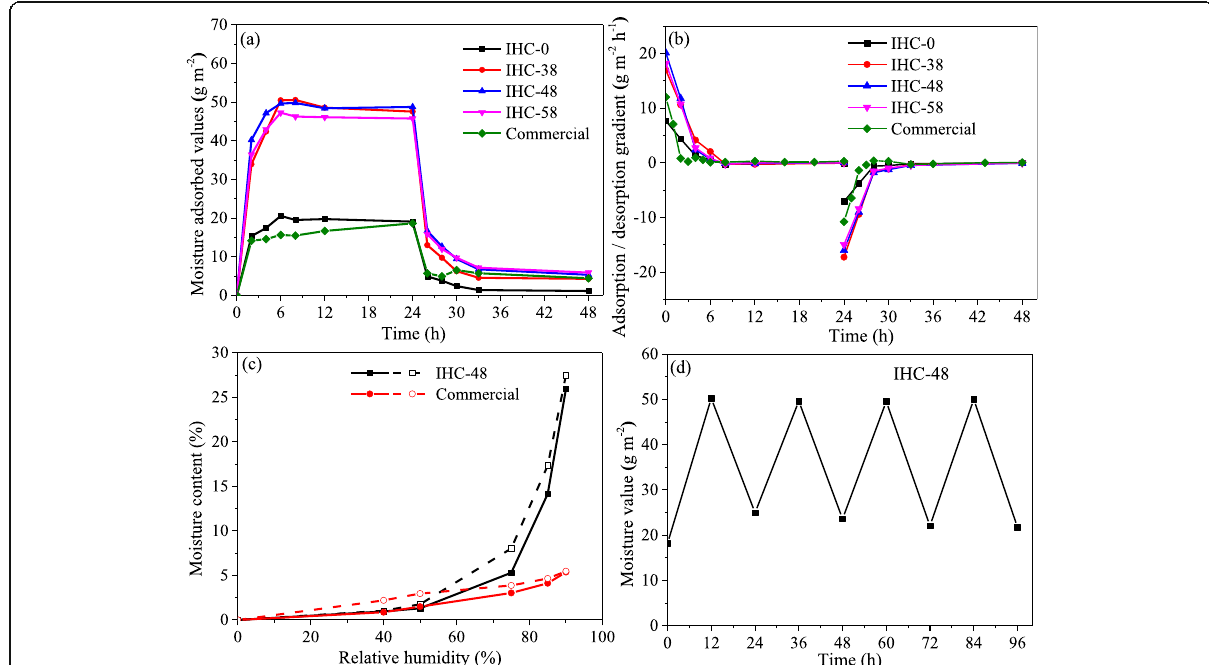
Fig. 8 A Moisture adsorption-desorption performance, ( B ) gradient, ( C ) hygroscopic curves f IHC-s and commercial samples and ( D ) a cyclic test of